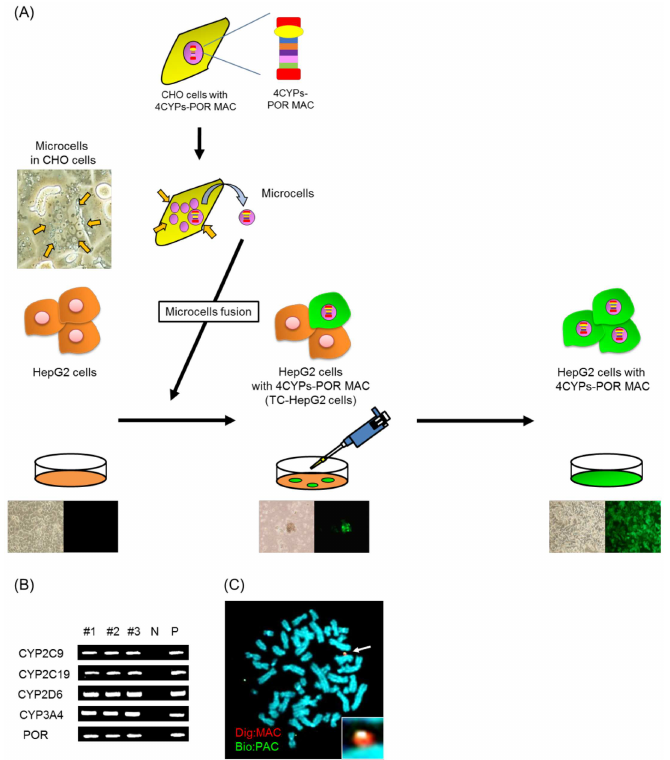
Fig 2. Analysis of HepG2 cells containing the 4CYPs-POR MAC. (A) Flowchart of the MAC transfer from donor CHO cells to recipientHepG2 cells via MMCT method, which comprisesthe followingsteps: micronucleation of donor cells by colcemid, enucleation by cytochalasin B, and microcellpurificationand fusion with recipient HepG2 cells. HepG2 hybrids were selectedwith 400 μ g/mL G418 and picked for clonal expansion. (B) G418-resistant clones are screenedby genomicPCR to determine the presenceof the 4CYPs-POR transgene. (C) Representative metaphasefluorescence in situ hybridizationimages of TC- HepG2 cells. Digoxigenin-labeledmouse cot-1 DNA (red) was used to detect the MAC. Biotin-labeled pPAC- 4CYPs-POR (green)was used to detect the 4CYPs-POR cassette in the MAC. Chromosomal DNA was counterstained with DAPI. White arrows indicate MAC vectors, and the inset shows an enlargedimage of the MAC.